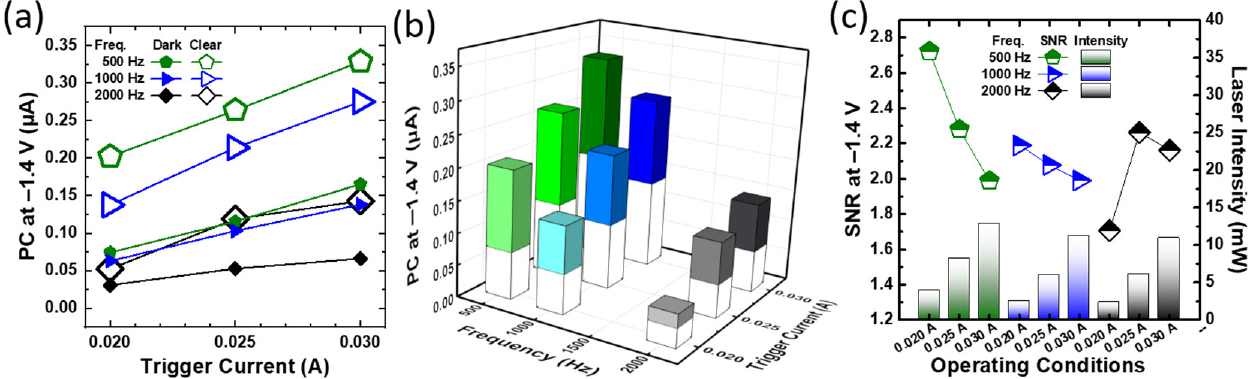
Figure 3. Photocurrent at − 1.4 V for the dark and clear zones under different trigger currents and AC frequencies: ( a ) scatter plot with connection line and ( b ) bar chart with different colors. All values of the dark zone are marked in white. ( c ) The signal-to-noise ratio and the intensity of laser illumination of different trigger currents and AC frequencies.